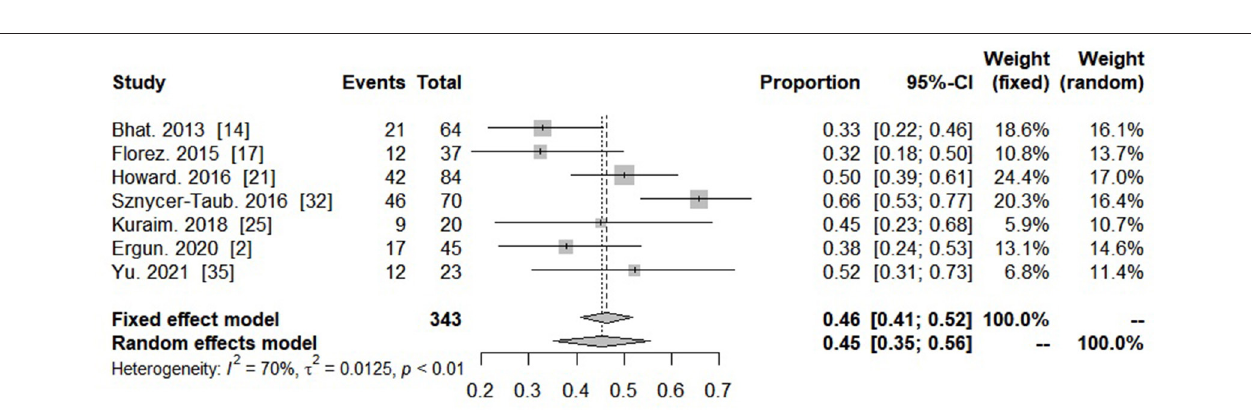
FIGURE 3 | Forest plot showing proportion of survivors in neonates with post-cardiotomy extracorporeal membrane oxygenation.